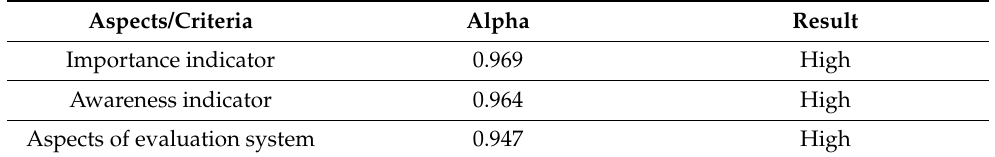
Table 2. The analysis of reliability (Cronbach α ).